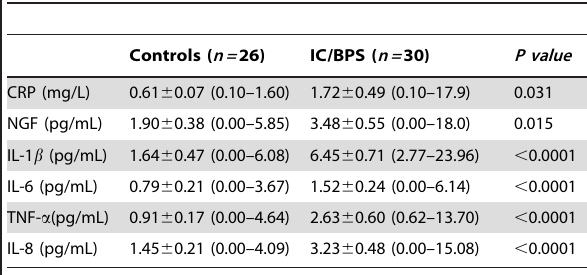
Table 1. Expression of serum CRP, NGF, IL-1 b , IL-6, TNF- a , and IL-8 in IC/BPS patients and controls.